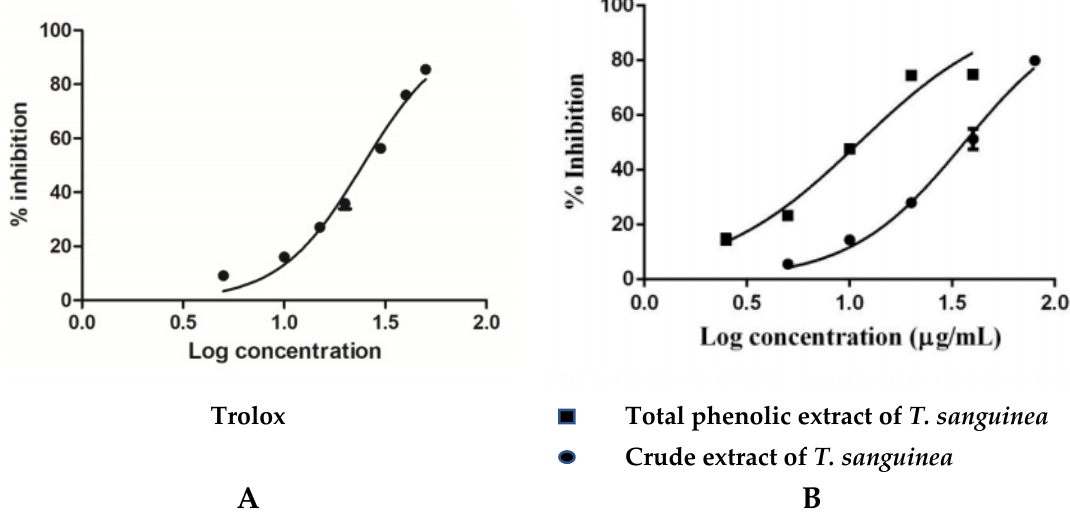
Figure 1. Chemical DPPH • scavenging rate by Trolox ( A ), T . sanguinea crude and phenolic extracts ( B ). All values are expressed as means (%) and SE of triplicated experiments.